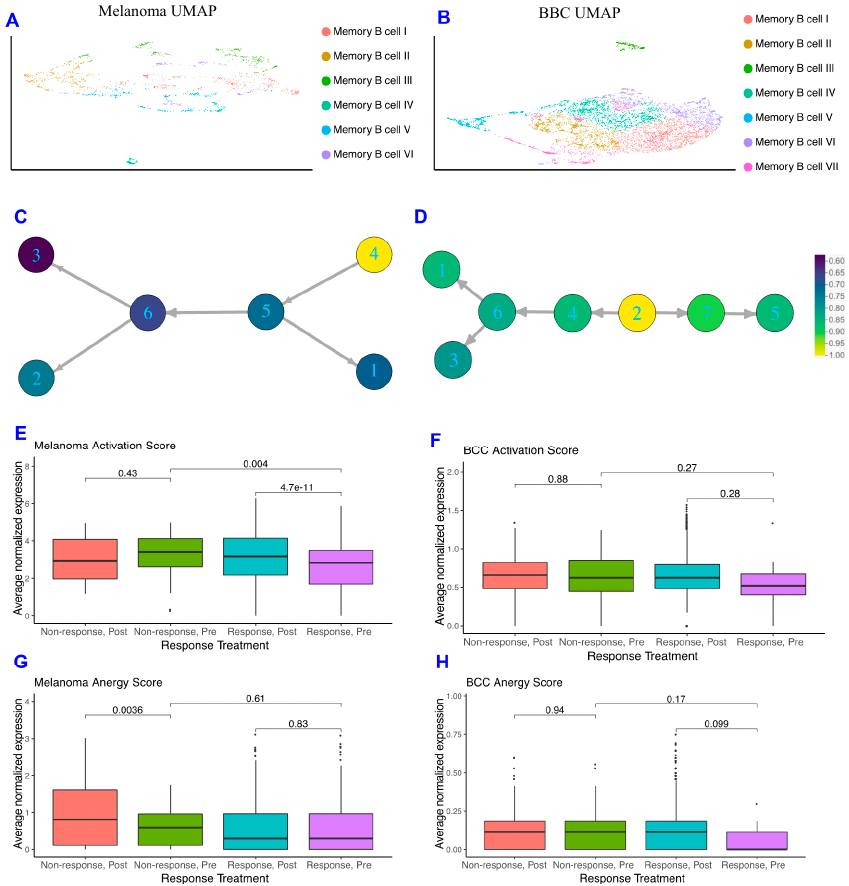
Figure 2. Memory B cells are more activated in non-responders pre response. ( A , B ) Dimensionality reduction of the memory B cells subsets of melanoma ( A ) and BCC ( B ). ( C , D ) Psuedotime ordering of melanoma ( C ) and BCC ( D ), colored by normalized activation score within each dataset. ( E , F ) Activation scores of memory B cells in melanoma ( E ) and BCC ( F ). ( G , H ) Anergy scores of memory B cells in melanoma ( G ) and BCC ( H ).